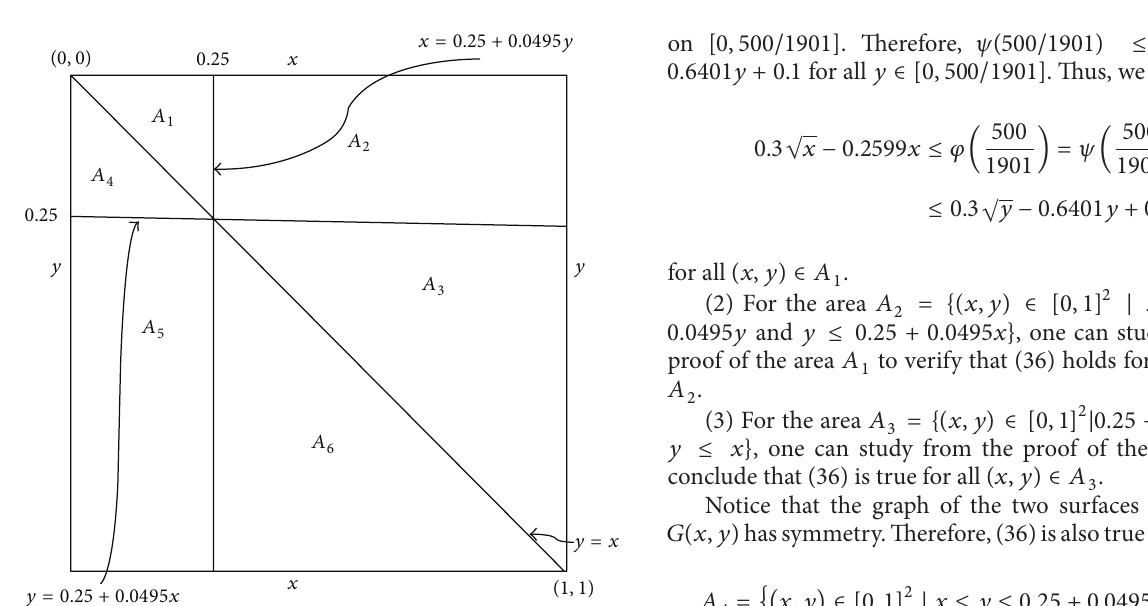
Figure 3: 𝐴 1 , 𝐴 2 ,𝐴 3 , 𝐴 4 ,𝐴 5 , and 𝐴 6 on the unit square.